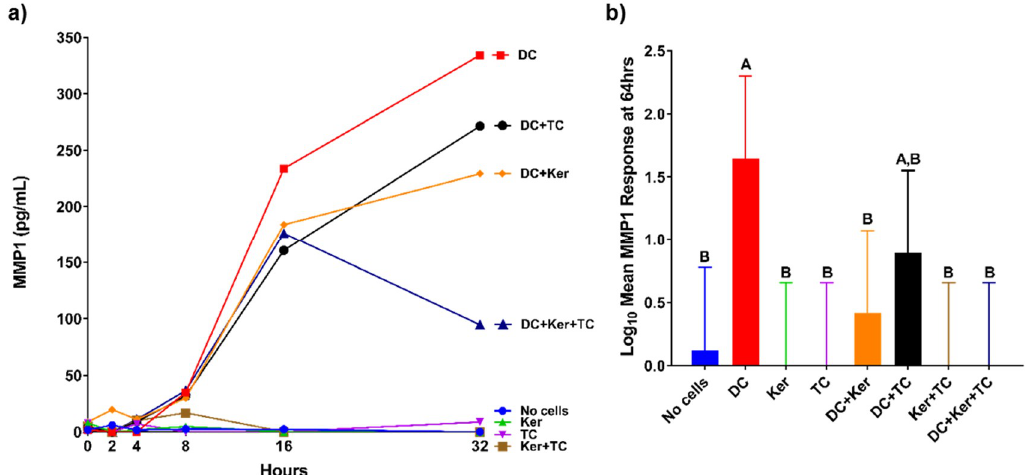
Figure 2. ( a ) Matrix metalloproteinase 1 (MMP1) responses of single cell and co-cultures when treated with hemagglutinin B (HagB) ( n = 3). HagB was added at Time 0 to single-cell cultures and co-cultures of T-cells (TC), GE keratinocytes (Ker), and dendritic cells (DC). MMP1 concentrations were determined at 0, 2, 4, 8, 16, and 32 h. The MMP1 responses from the HagB diluent were subtracted from the HagB-induced MMP1 responses. ( b ) MMP1 responses to HagB at 64 h ( n = 9). The MMP1 responses from the HagB diluent were subtracted from the HagB-induced MMP1 responses. A two-way fixed effect ANOVA was fit to log-transformed concentrations of MMP1. Pairwise group comparisons were conducted using the post-hoc Tukey’s honest significance test. A 0.05 level was used determine statistically significant differences between groups. Shared letters above bars indicate the groups are not statistically different from one another ( p > 0.05), while differing letters indicate significantly different mean values ( p < 0.05).